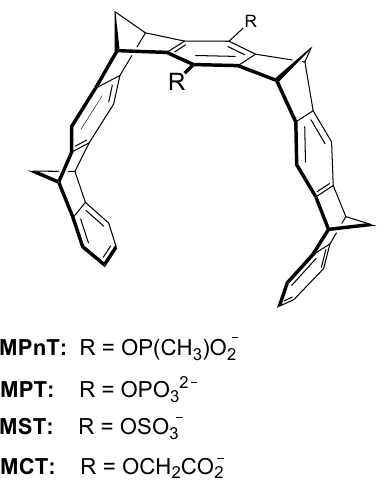
Figure 15. Structure of the Molecular Tweezers reported in Schradder et al. functionalized with phosphonate (MPnT), phosphate (MPT), sulfate (MST), and carboxylate (MCT).